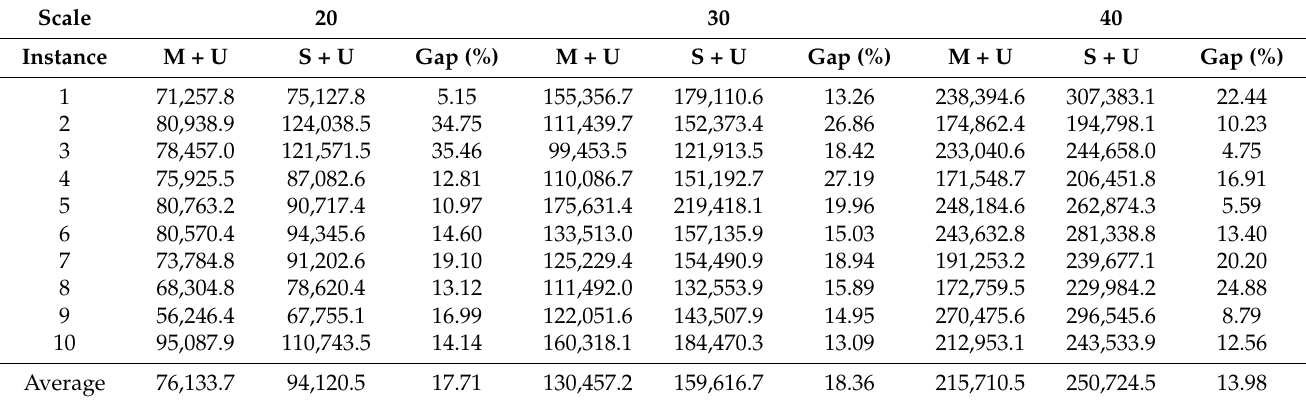
Table 6. The objective value of solutions under S + U and M + U.